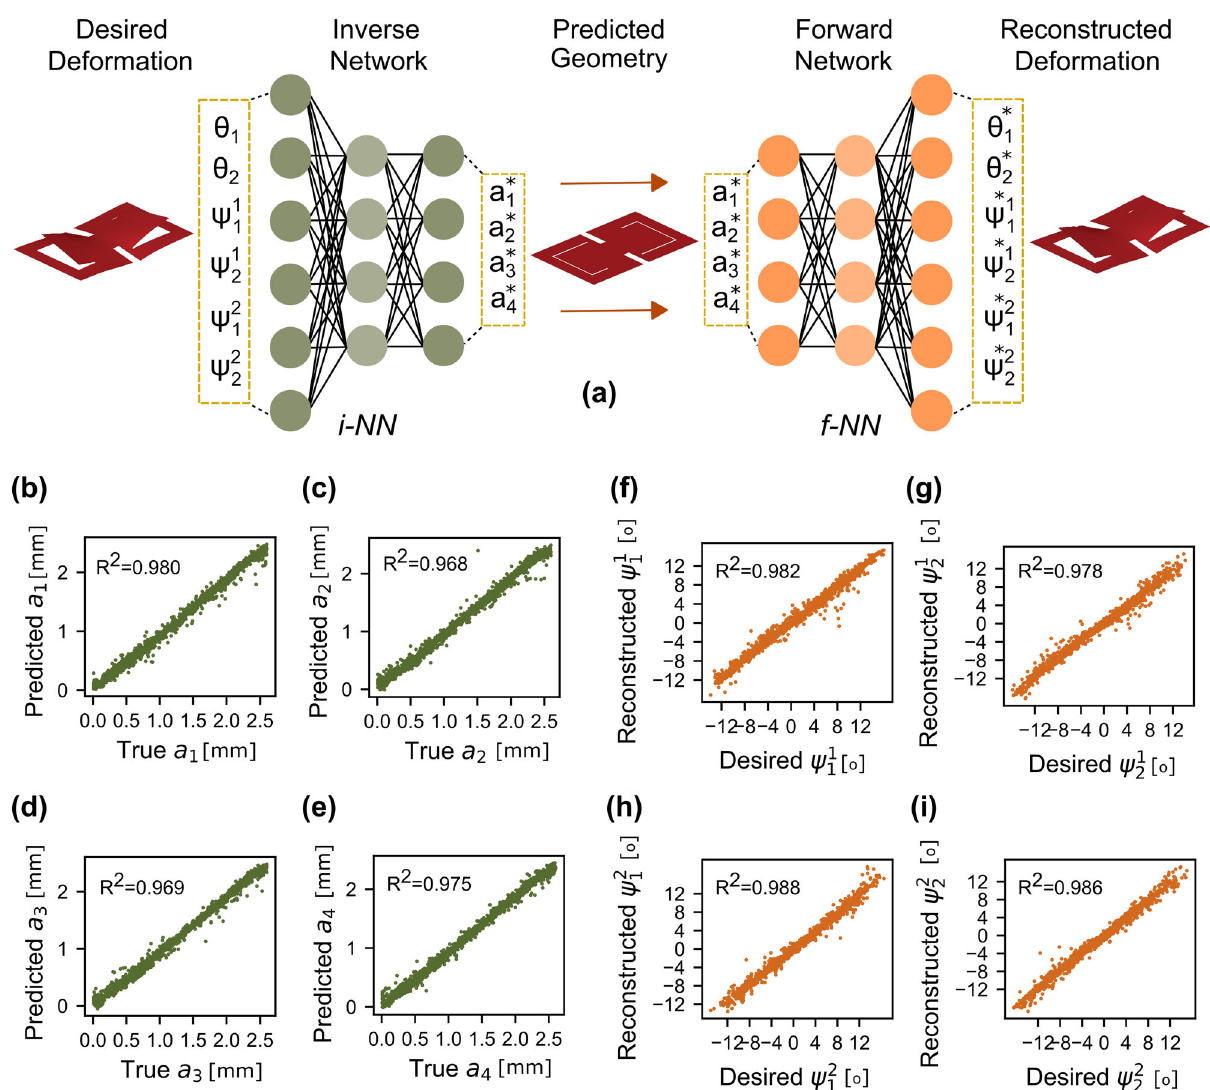
Fig. 4 Machine learning framework for inverse design. a Schematic of the tandem network architecture employed for the inverse design. The inverse network ( i-NN ) takes in the desired deformed con fi guration ( θ 1 (cid:1) 2 ; ψ 1 (cid:1) 2 predicted geometric features ( a (cid:4) ) are fed to the pretrained f-NN to reconstruct the angles of the deformed con fi guration ( θ (cid:4) 1 (cid:1) 4 thereafter validate the predictions of the i-NN . b – e i-NN predicted a 1 − 4 vs true a 1 − 4 . f – i f-NN reconstructed ψ 1 (cid:1) 2 corresponding coef fi cient of determination (R 2 ) are speci fi ed on the respective